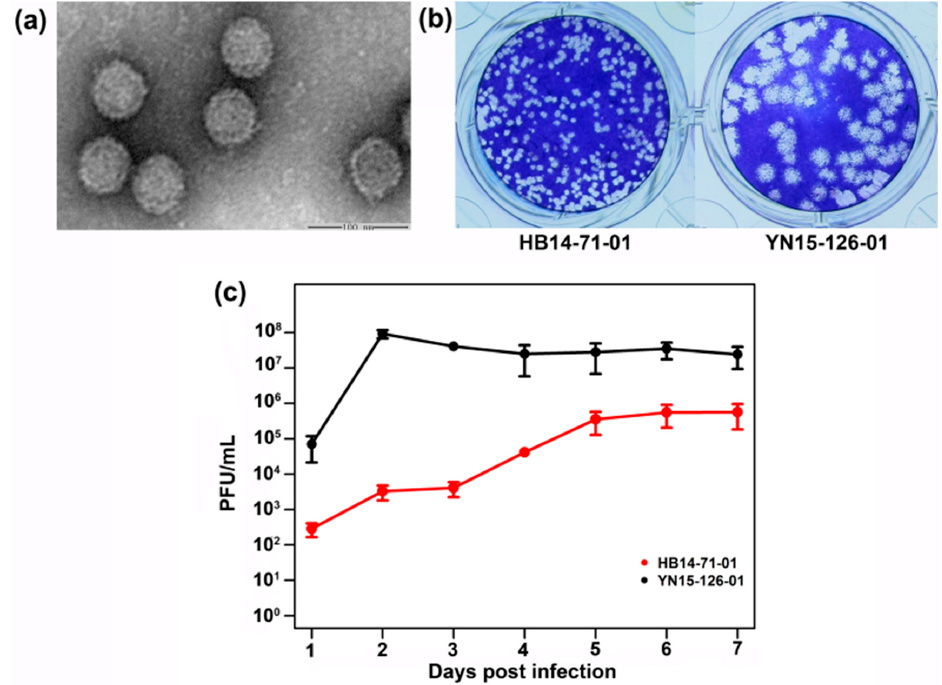
Figure 1. Viral particle, plaque, and growth kinetics for Banna virus (BAV) HB14-71-01. ( a ) Purified viral particles of BAV HB14-71-01 were observed under an electron microscope (EM); ( b ) viral plaques of BAV HB14-71-01 and YN15-126-01 in the C6/36 cells; ( c ) growth kinetics of BAV HB14-71-01 and YN15-126-01 in C6/36